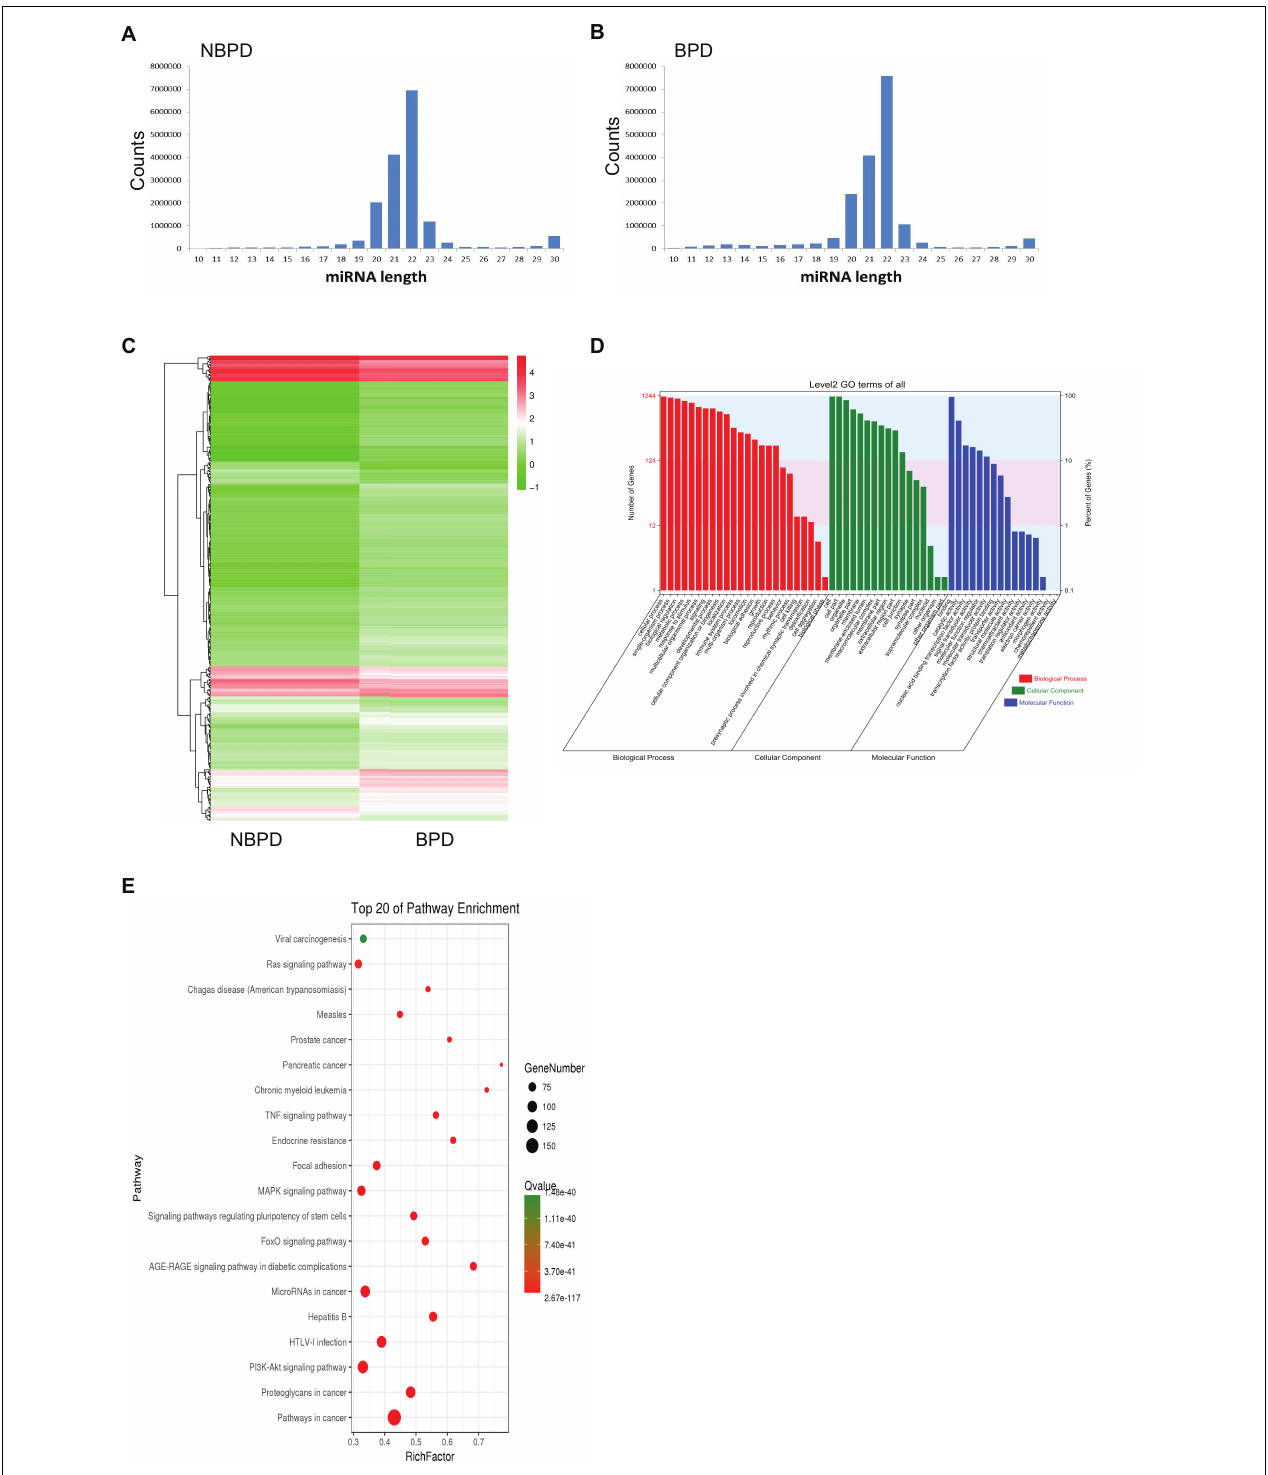
FIGURE 3 | EXO-miRNA profile of umbilical cord blood from NBPD and BPD infants and the bioinformatics analysis of DE miRNAs. (A,B) The length distribution of EXO-miRNAs in NBPD and BPD patients. (C) Heat map of DE EXO-miRNAs between NBPD and BPD patients. (D) GO analysis results showing the functional categorization of DE miRNAs between NBPD and BPD infants. (E) KEGG pathway analysis showing the top 20 enriched KEGG pathways for DE EXO-miRNAs. n = 4.